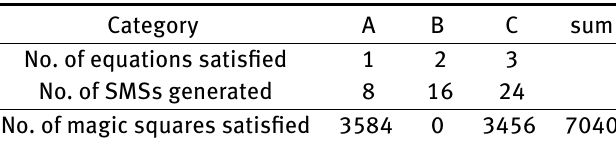
Table 2: The result of R-C similar transformations of order four Category A B C sum No. of equations satisfied 1 2 3 No. of SMSs generated 8 16 24 No. of magic squares satisfied 3584 0 3456